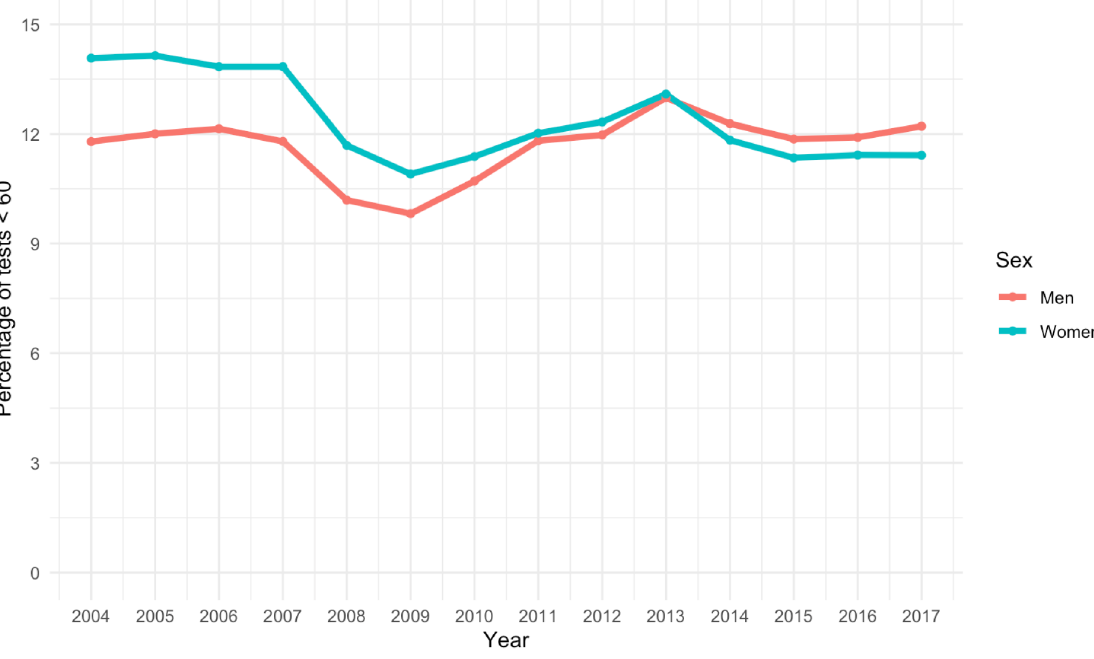
Figure 3: Prevalence of eGFR < 60 mL/min/1.73 m 2 in Tasmania using a single measure (first test) in a calendar year